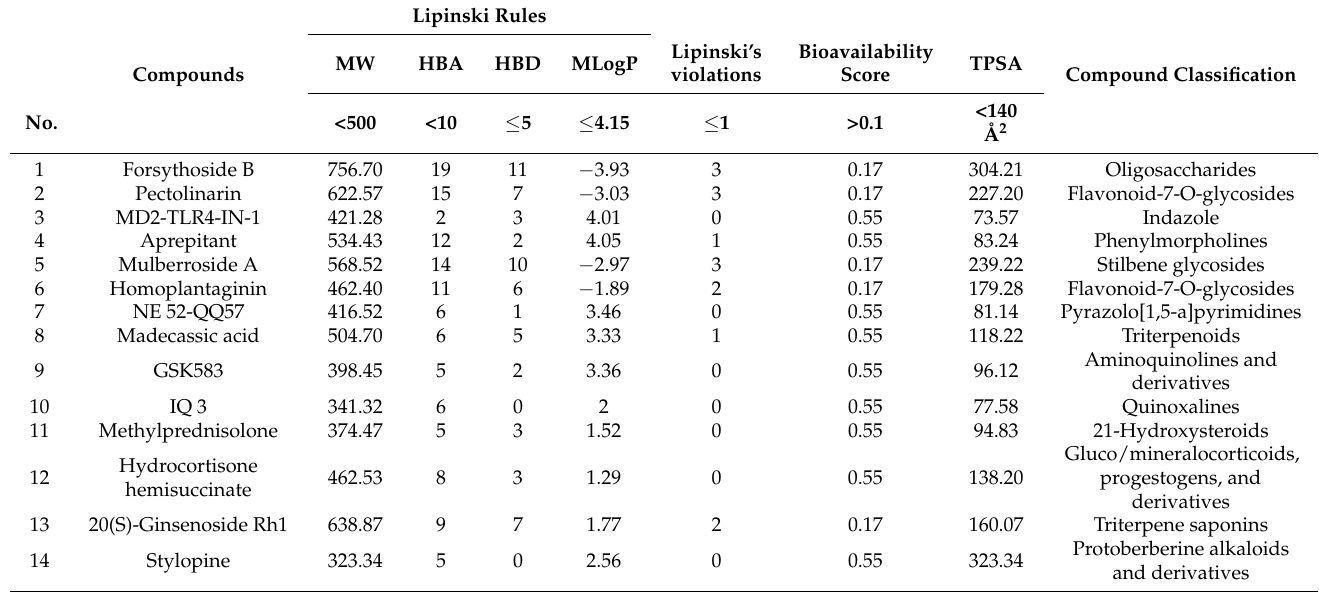
Table 2. The physicochemical properties and classification of 31 compounds as IL-6